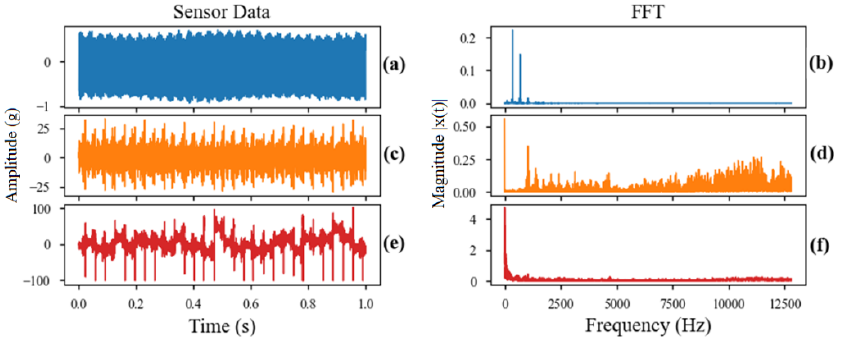
Figure 7. Sensor A signals. ( a ) Healthy, ( b ) Healthy FFT, ( c ) Fault-1 ( d ) Fault-1 FFT, ( e ) Fault-2, ( f ) Fault-2 FFT.